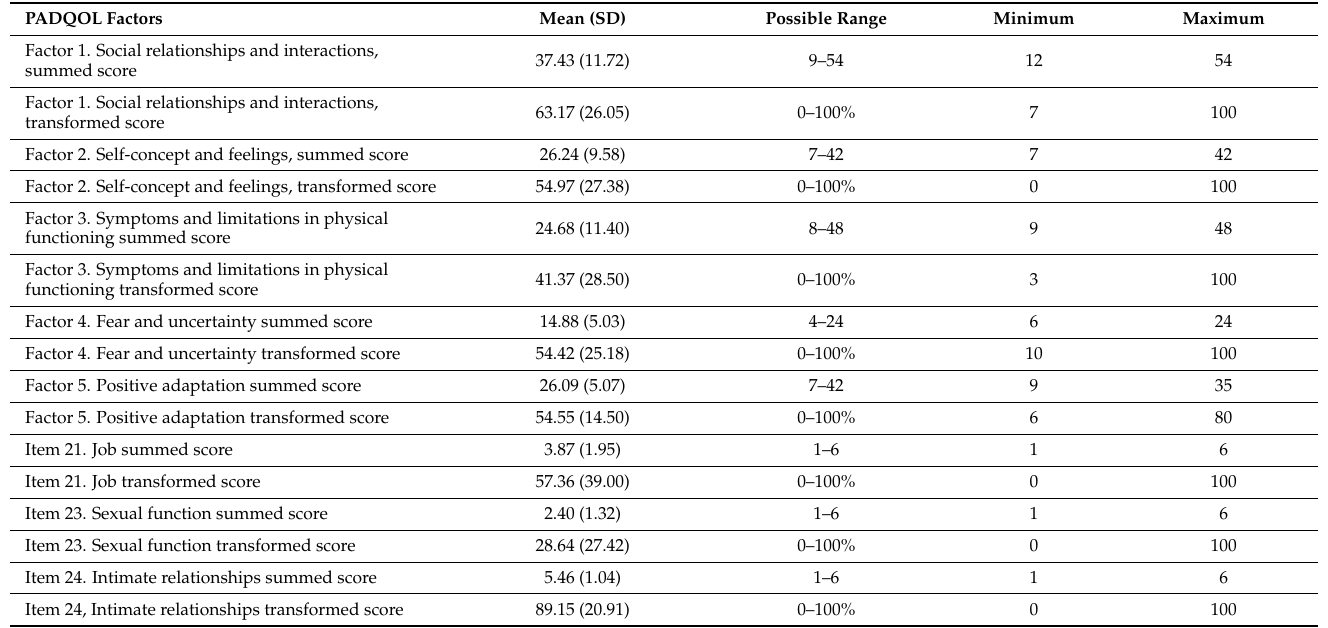
Table 4. The PADQoL questionnaire survey